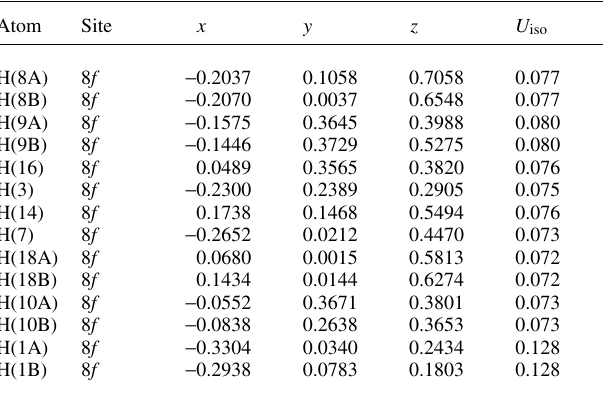
Table 2. Atomic coordinates and displacement parameters (in Å 2 )